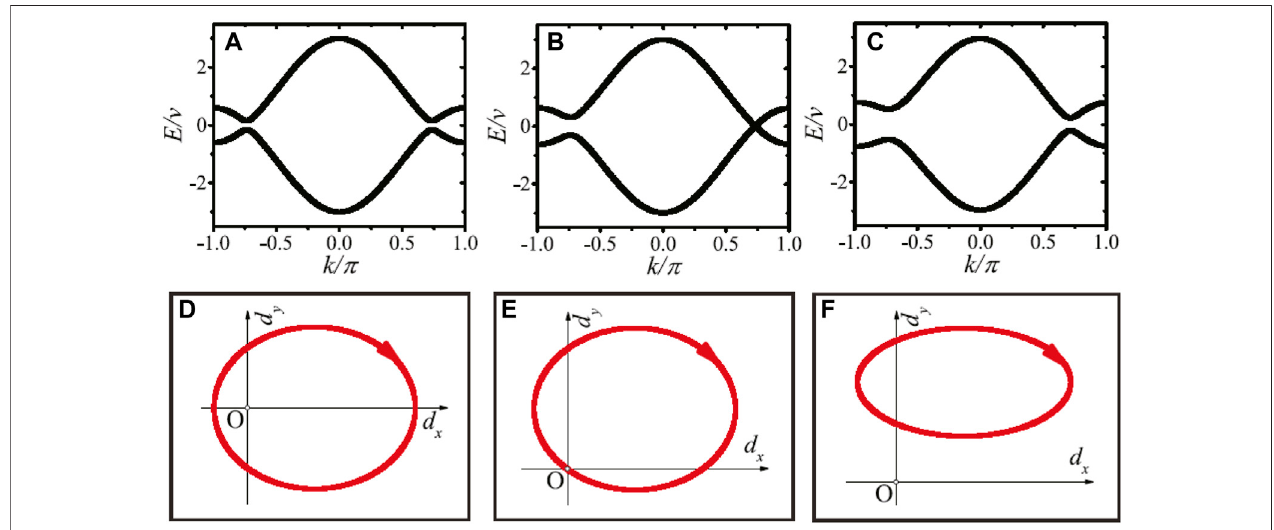
FIGURE4| (Coloronline)DispersionrelationsofthegeneralizedSSHmodelforhoppingamplitude J / v (cid:1) 1.2withdifferentphase: (A) ϕ (cid:1) 0; (B) ϕ (cid:1) ϕ c ≈ 0.04; (C) ϕ (cid:1) 0.1. (D – F) The paths ofthe endpoint of thevector d ( k ),correspondingto (A – C) , are shown on the d x , d y plane asthe wavenumber is sweeped across the Brillouin zone, k (cid:1) 0 → 2 π . The other parameter is z / v (cid:1) 0.8.